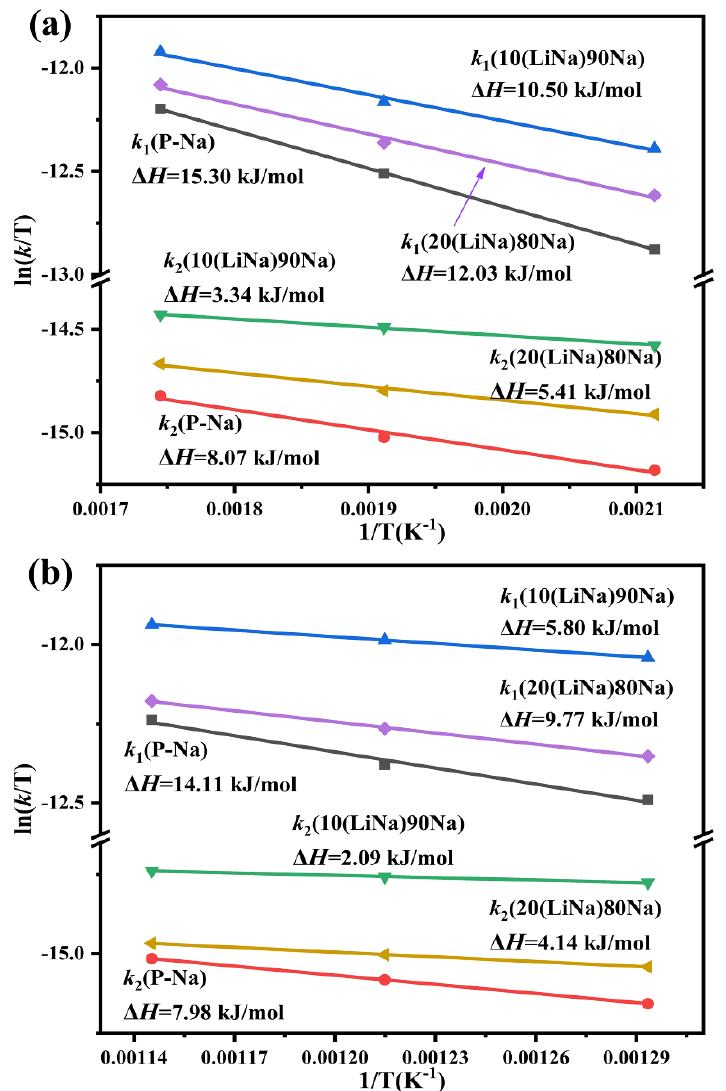
Figure 6. Eyring type profiles of k 1 and k 2 for different samples at( a ) 200–300 °C and ( b )500–600